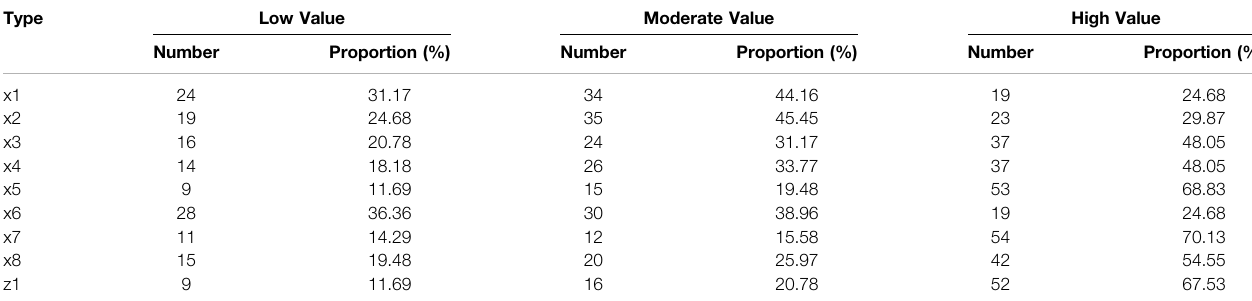
TABLE 3 | The number and proportion of counties and districts at different intervals of